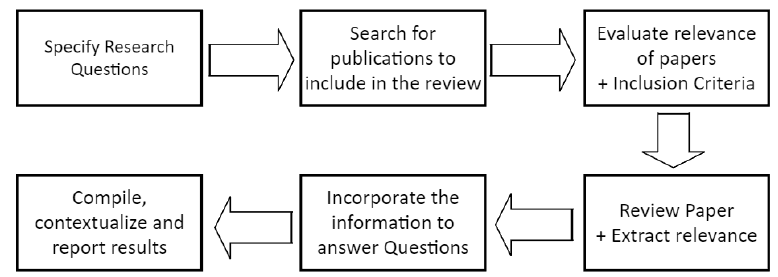
Figure 1. Method of approach to the